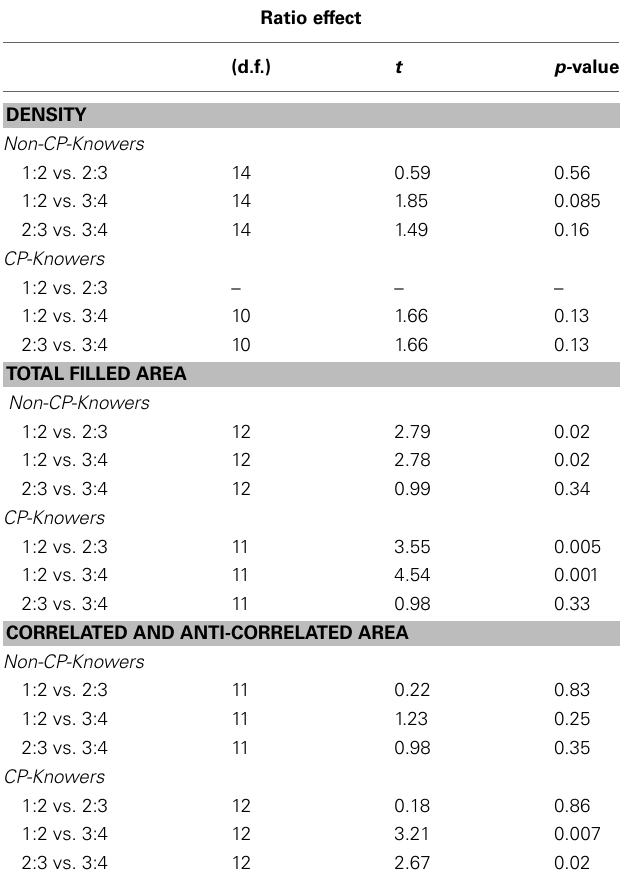
Table 1 | Statistics for the ratio effect divided by visual control and cardinality